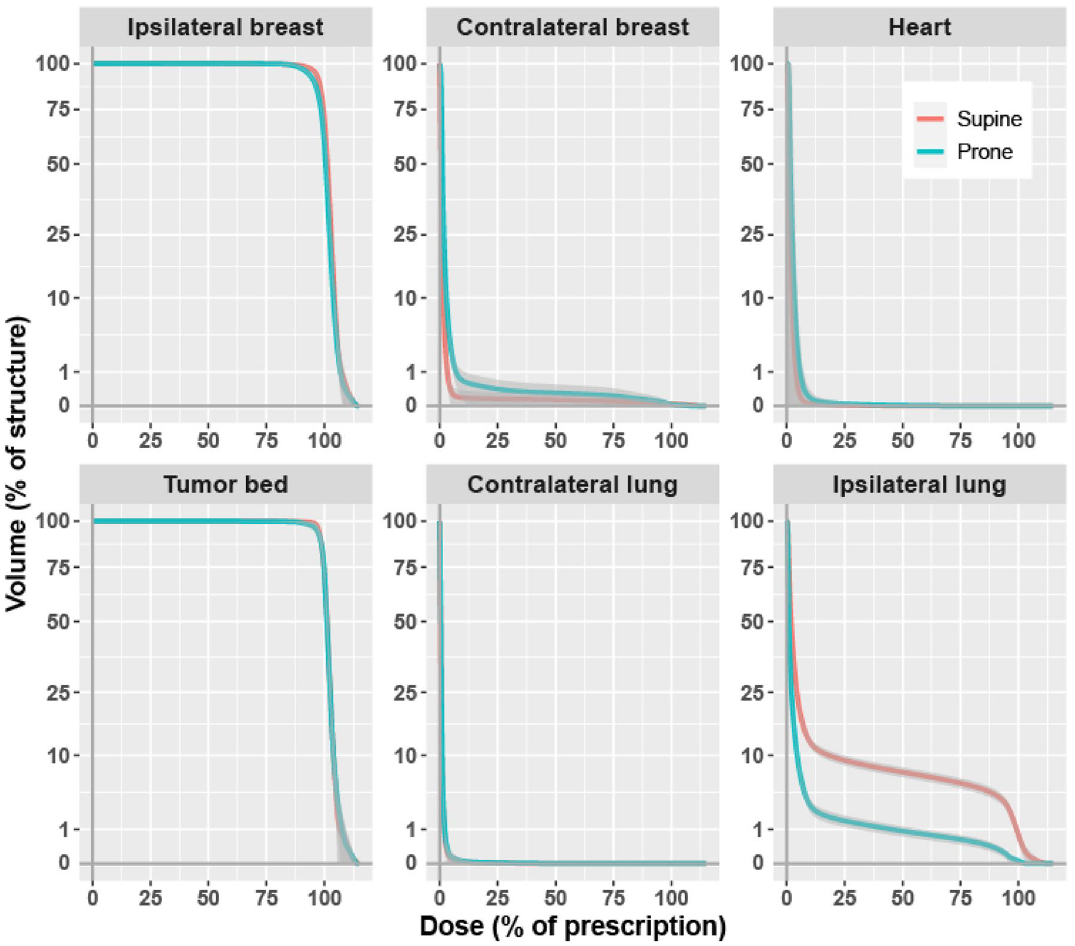
Figure 1. Averaged cumulative dose-volume histograms by structure and setup. Volume, square root scale. Dark grey, 99% confidence